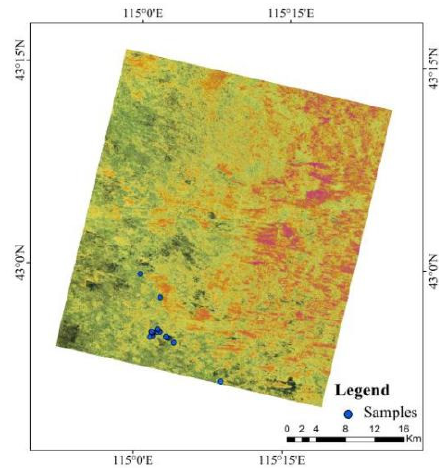
Figure 2. The distribution of field data.